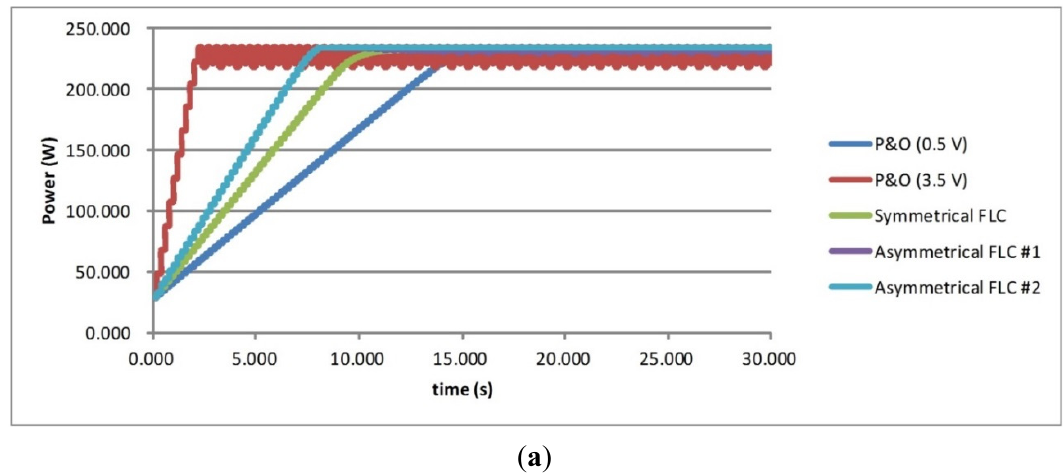
Figure 14. Measured starting waveform of five different algorithms when irradiance level is 200 W/m 2 (Starting from the right-hand side). ( a ) Simulated results; ( b ) Measured results.